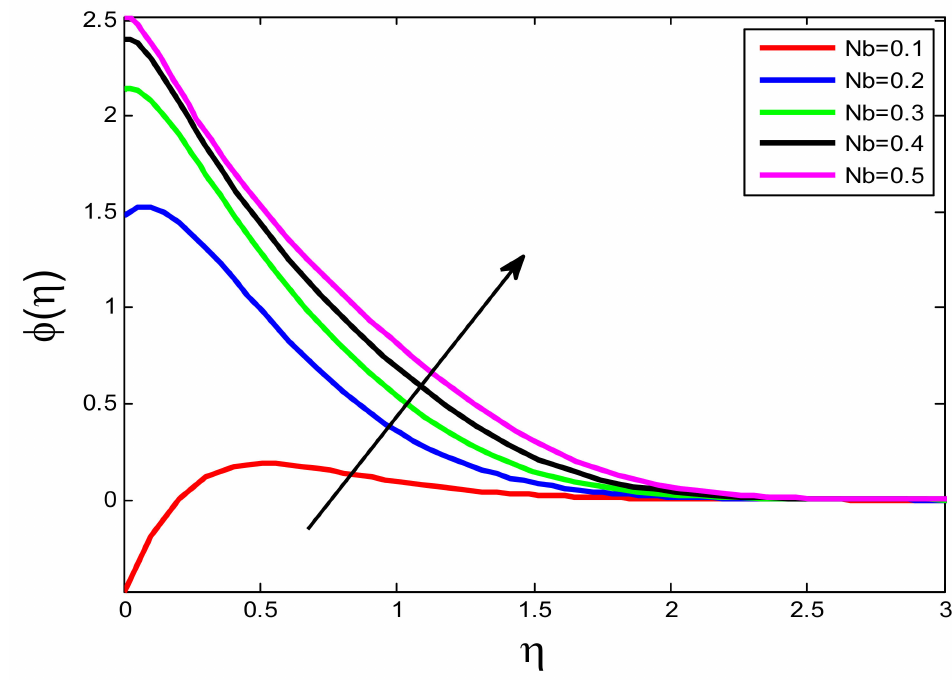
Figure 20. Influence of Nb on φ ( η ) .